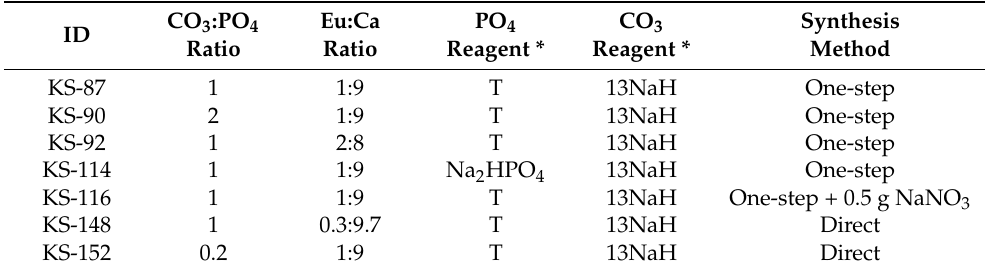
Table 1. Conditions for the synthesis of prepared